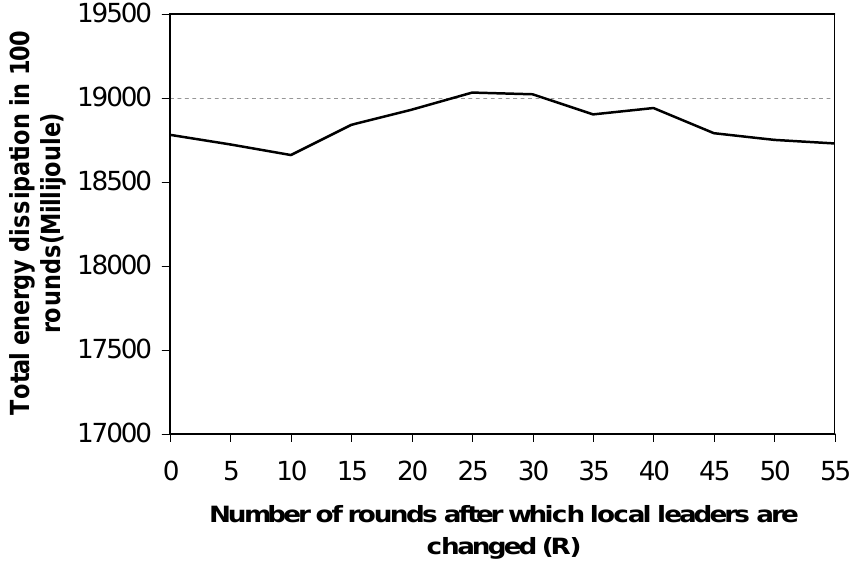
Figure 13. Leader selection time vs . total energy